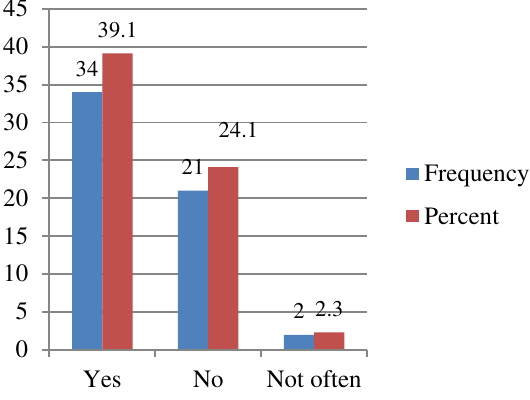
Fig. 11. Respondents abkout customer involvement in a new product planning.